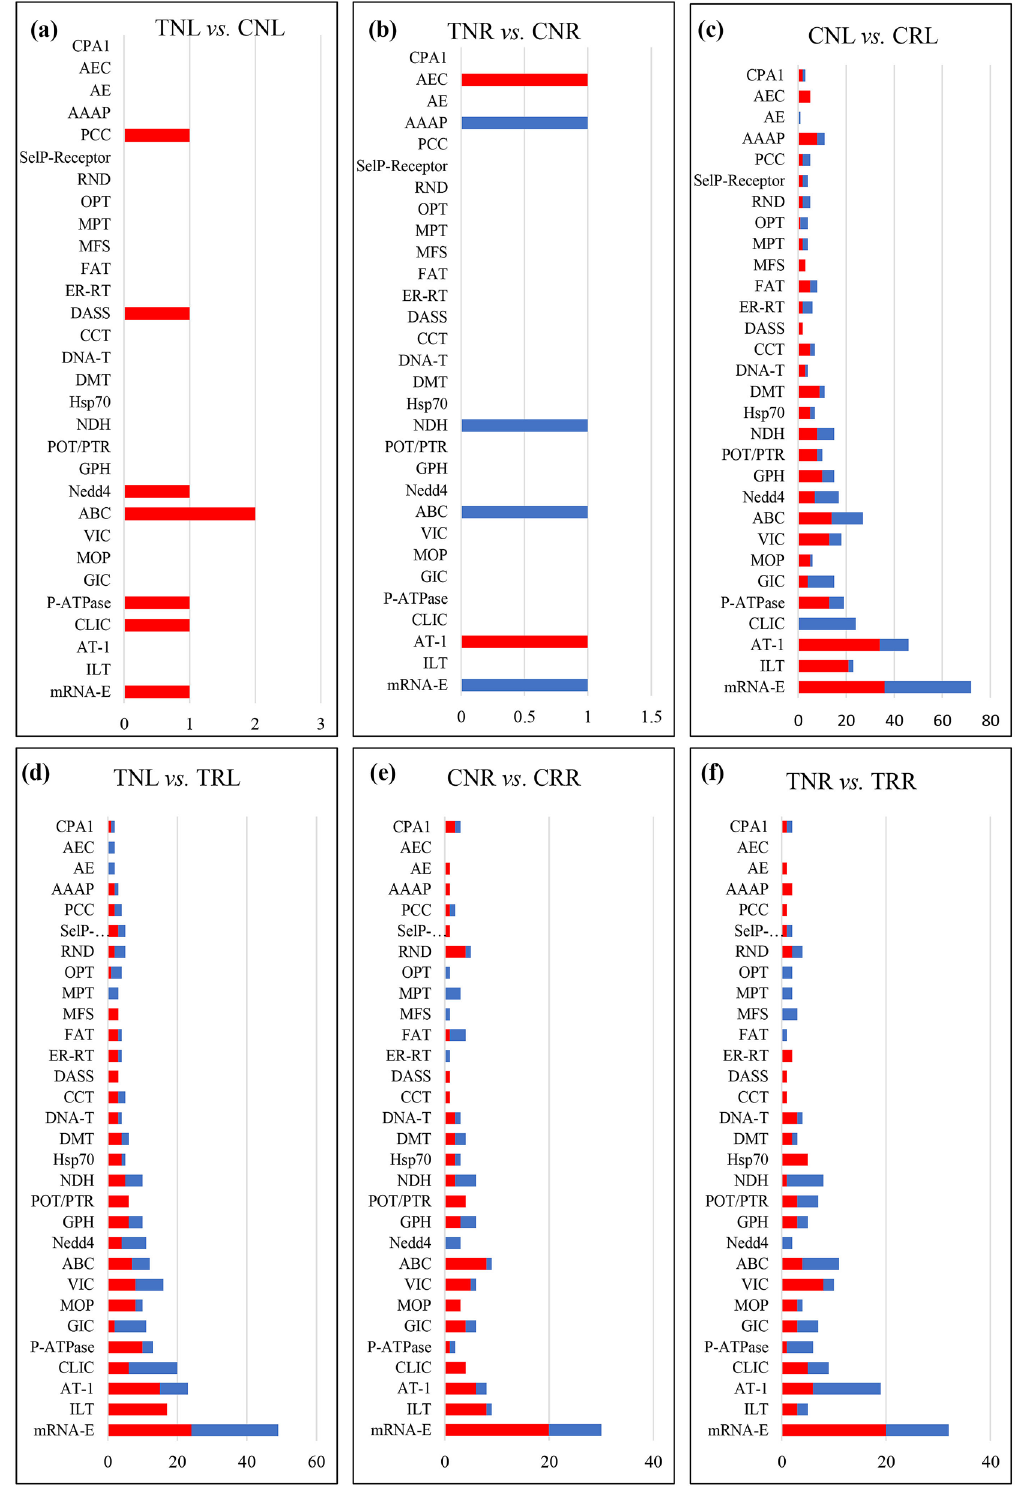
Figure 5. Transporter analysis of DEGs. The Y -axis indicates transporter superfamilies. The X -axis shows gene counts. Salt treatment versus control comparisons are shown in ( a ) and ( b ). Salt-sensitive versus salt-tolerant comparisons are shown in ( c )–( f ). The red color indicates downregulated DEGs, and the blue color indicates upregulated DEGs. Compared samples are indicated at the top of each